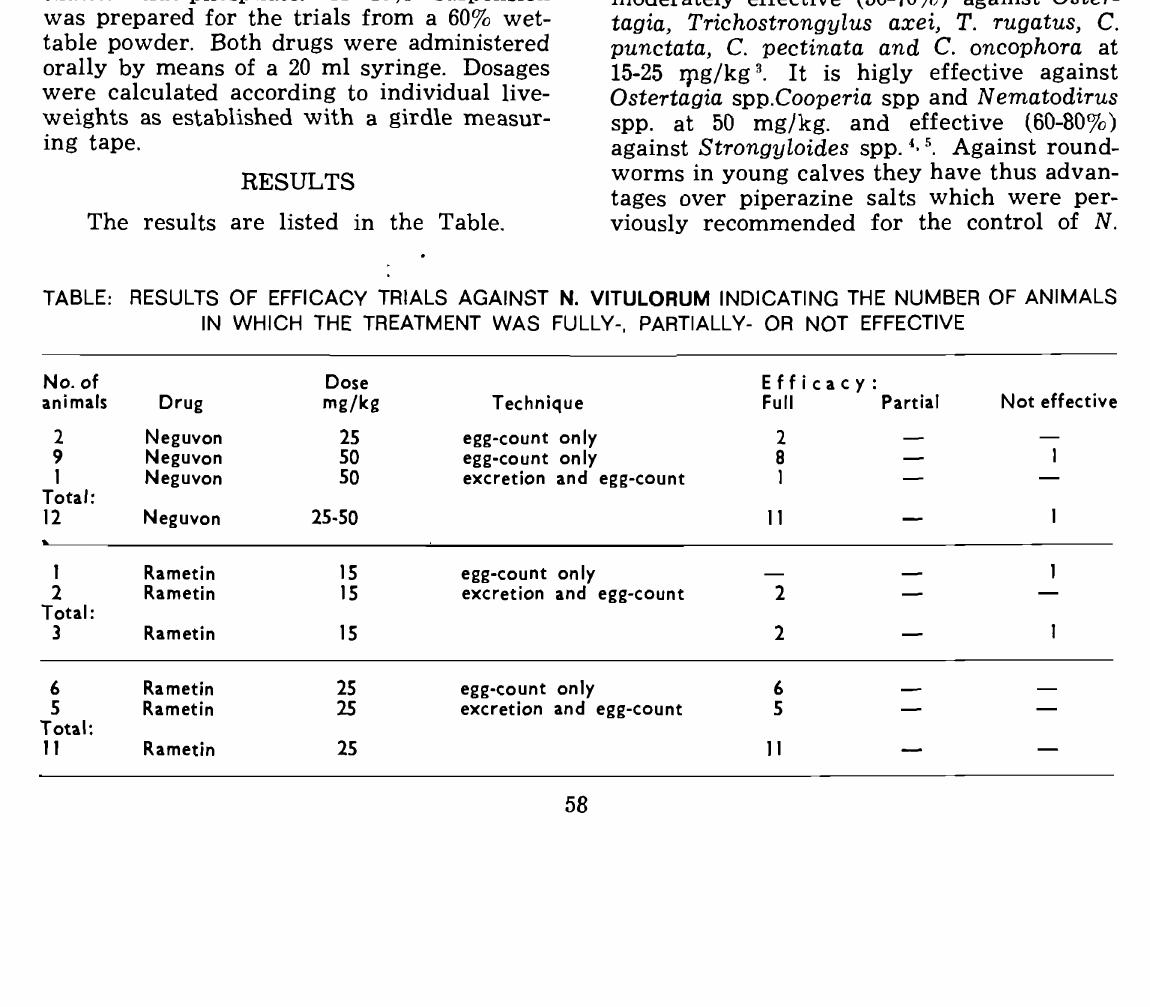
table powder. Both drugs were administered orally by means of a 20 ml syringe. Dosages were calculated according to individual live weights as established with a girdle measur ing tape. The results are listed in the Table. TABLE: RESULTS OF EFFICACY TRIALS AGAINST N. VITULORUM INDICATING THE NUMBER OF ANIMALS IN WHICH THE TREATMENT WAS FULLY-, PARTIALLY- OR NOT EFFECTIVE No.